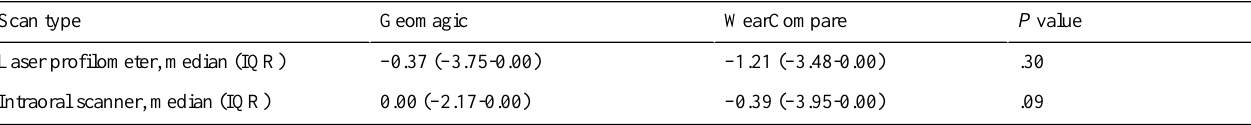
Table 1. Volume changes (mm 3 ) observed over 3 years when positive data were set to zero, which is a commonly used method by many commercial